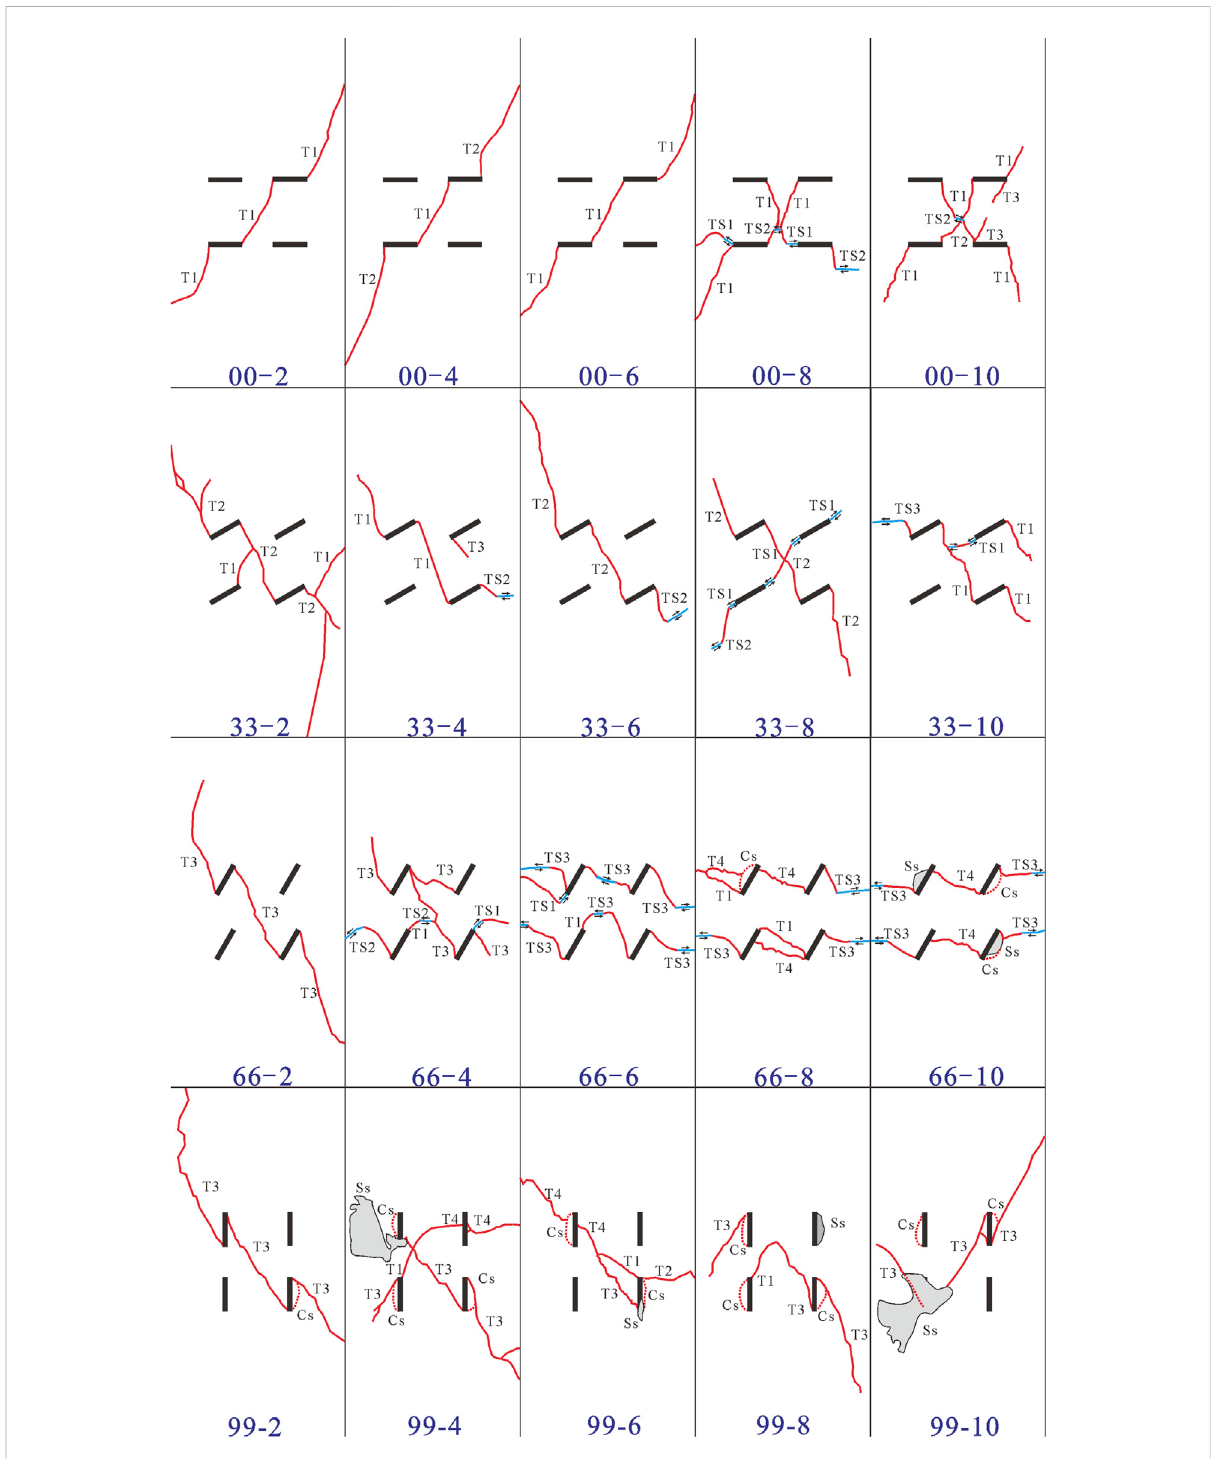
FIGURE 4 Various crack types observed in the ultimate failure of all